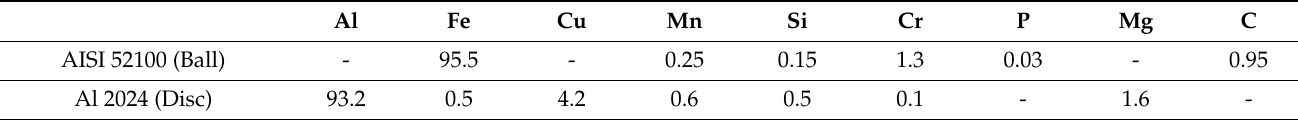
Table 2. Composition of ball and disc materials (weight